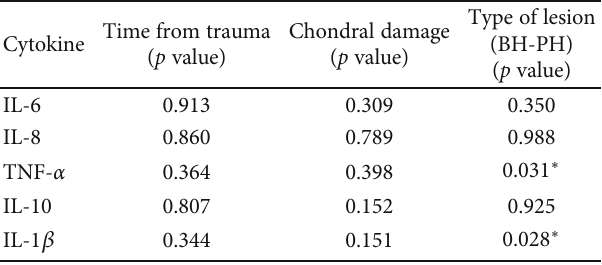
Table 2: E ff ects of time from trauma, chondral damage, and type of lesion on the cytokine levels of medial meniscal tears.